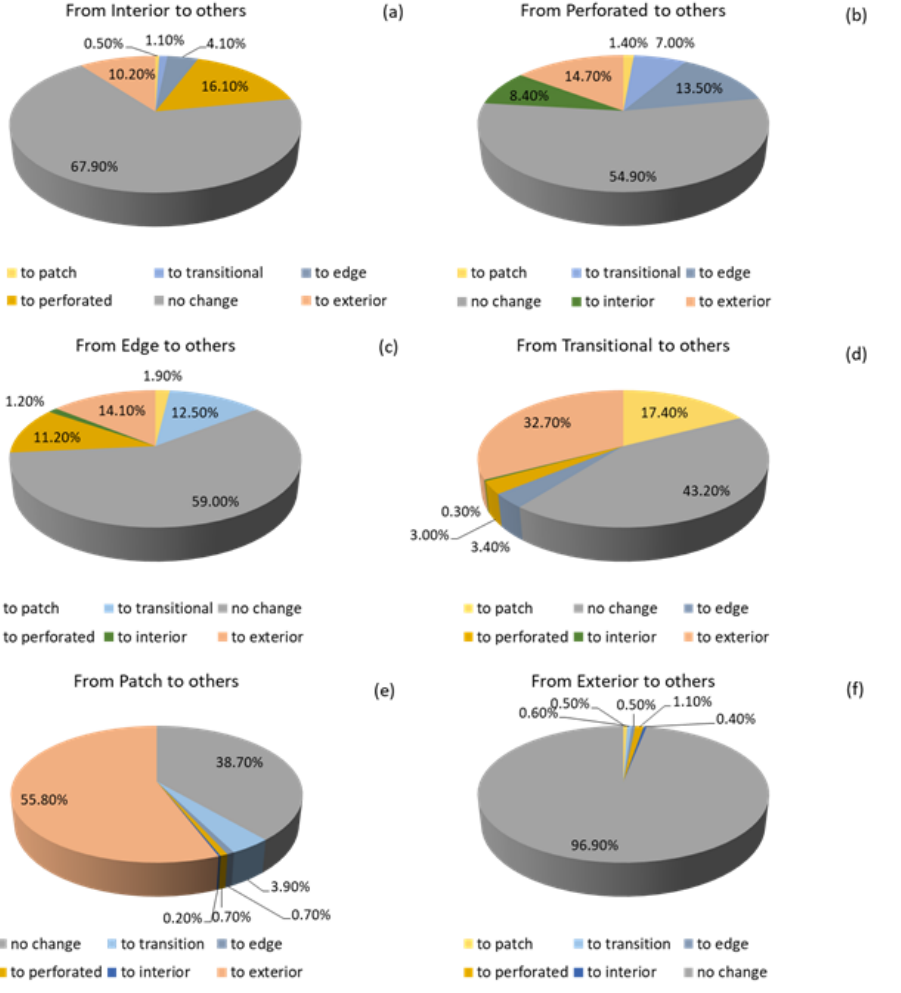
Figure 4. Changes in areas of various fragmentation categories during 2008–2018.